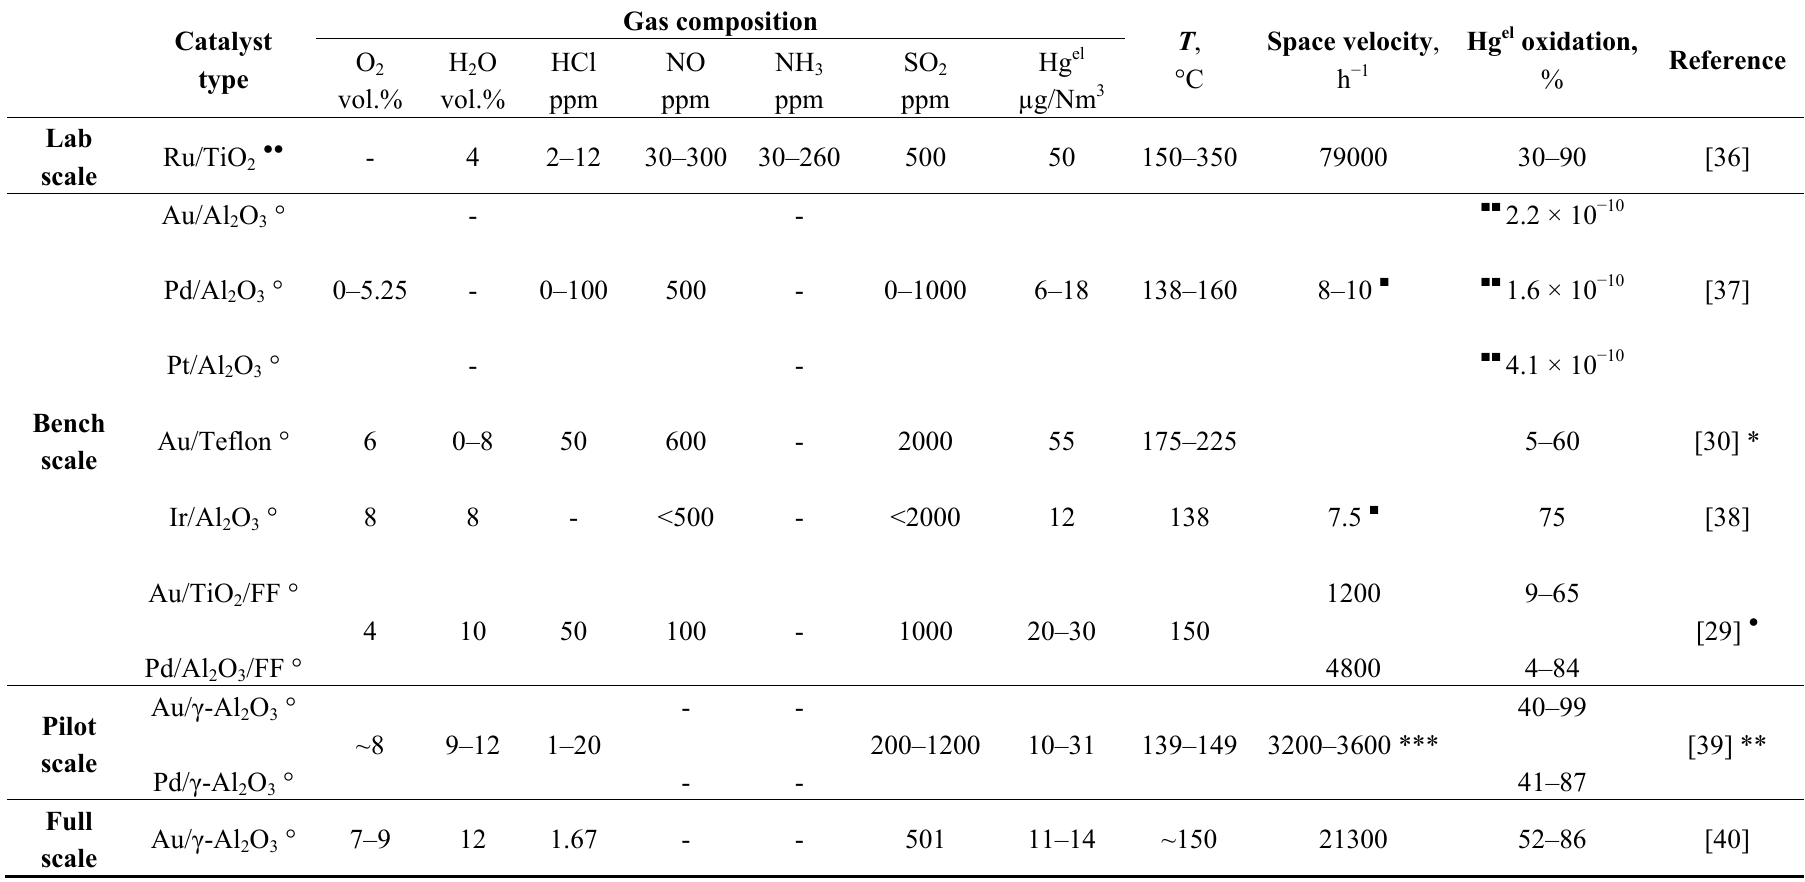
Table 1. Mercury oxidation over noble metal based